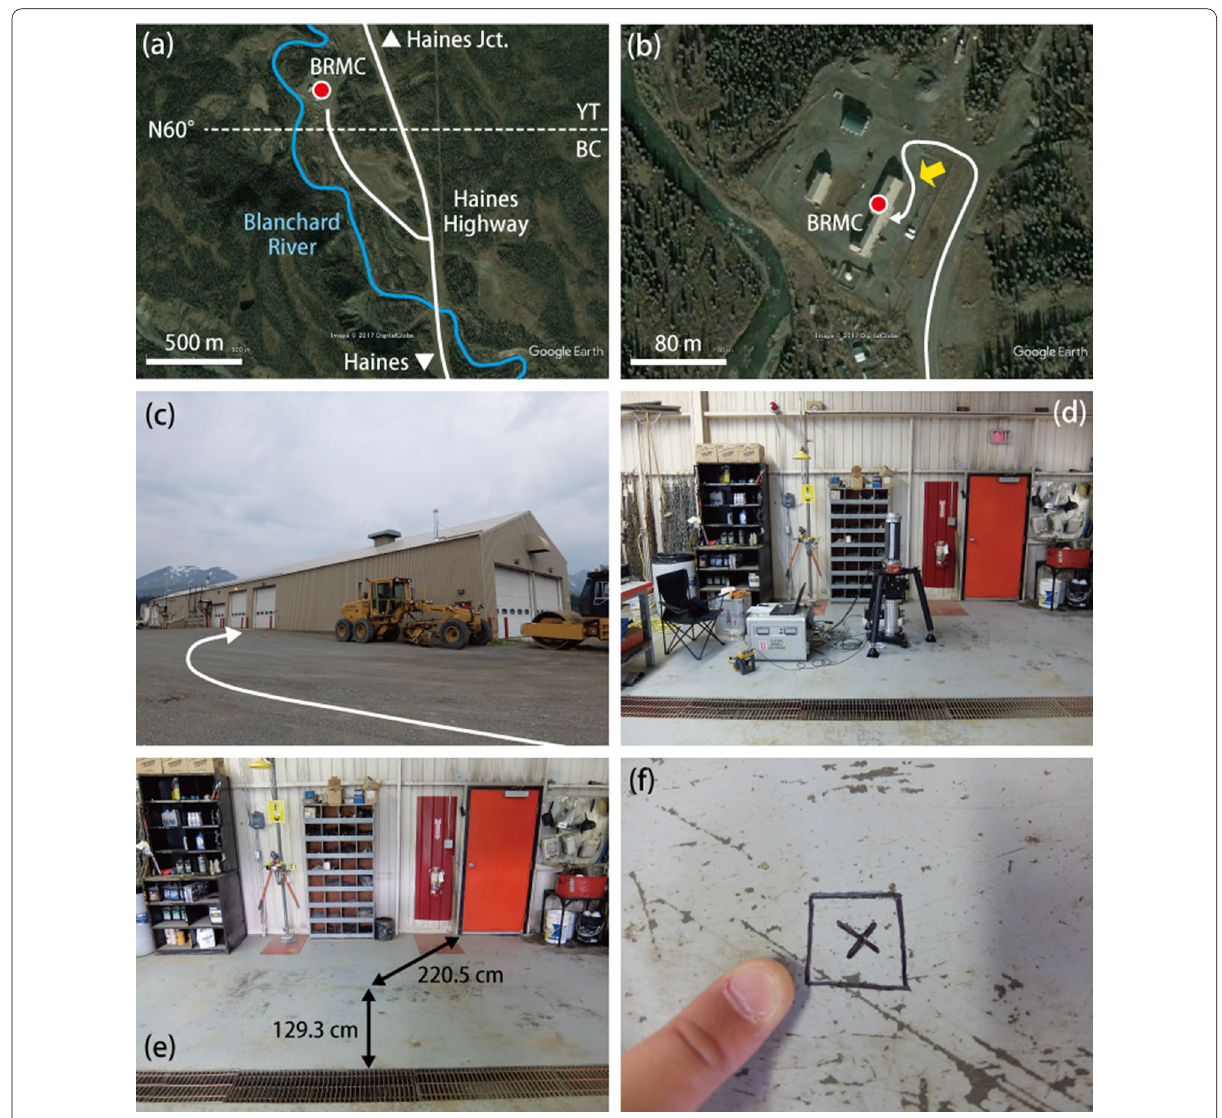
Fig. 15 Location of the BRMC gravity point. a Satellite image of the vicinity of BRMC derived from Google Earth Pro. The dashed line indicates the 60th parallel north, which corresponds to the border between the Yukon Territory (TY) and British Columbia (BC), Canada. When you access to BRMC (red circle), drive a van along the Haines Highway northward from Haines, and turn left after crossing over the Blanchard River. b Satellite image of BRMC derived from Google Earth Pro. The white line and yellow arrow indicate the access route to BRMC and the direction of the photo ( c ), respectively. BRMC (red circle) is located in the garage. c Garage of Blanchard Road Maintenance Compound. The white line indicates the access route to BRMC by car. The shutters at the tip of the white arrow can be opened when you transport AG instruments closely to the gravity point. d FG5-111 absolute gravimeter on the AG point. e Exact position of the AG point. It is located 129.3 cm from the corner of the gutter, and 220.5 cm from the corner of the red door. f Close-up photo of the AG point. This AG point was originally indicated with scratch marks of a small cross and a large square in and before 2012. However, the garage floor was painted by compound staff after the AG measurement in June 2012. Since we could not easily find the marks under the painting in June 2013, we highlighted the marks with a permanent marker for future AG